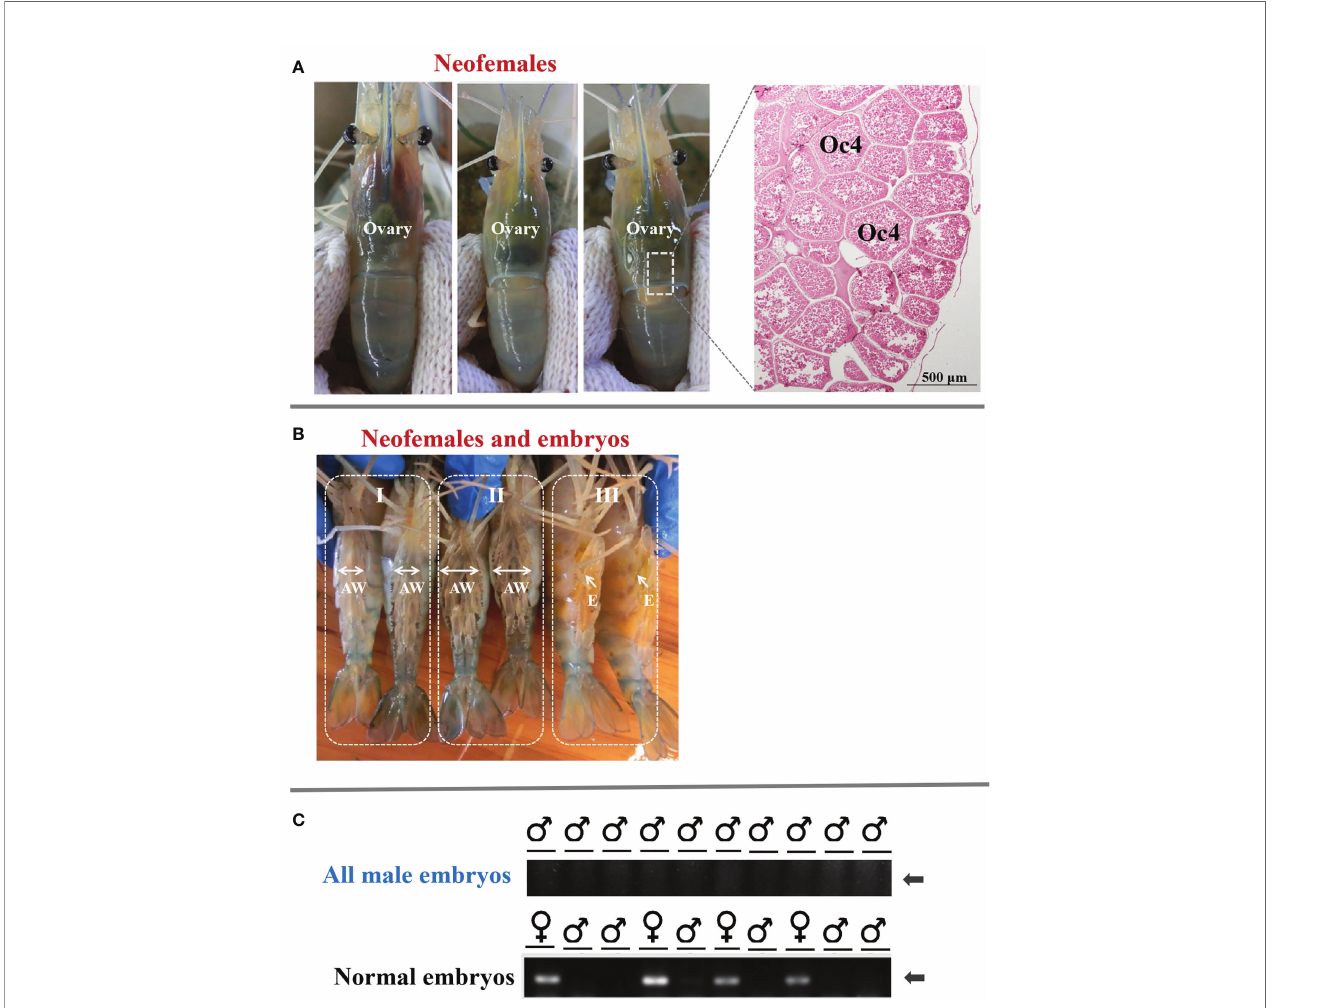
FIGURE 2 | The ovarian development of full-functional sex reversal prawn and the breeding of all-male progeny by MroDmrt11E -silenced prawn (neo-females). (A) The ovarian development and maturation of neo-females. The inset photograph indicated the histology of the mature ovary of neo-females. The ovary was full of mature oocytes (Oc4) that were intensely eosinophilic (reddish orange). (B) Ventral view of MroDmrt11E -silenced prawn (neo-females) incubating embryos in their brood chamber. The mature neo-females (B-I) spawned and incubated the embryos in their brood chambers, located ventrally on their enlarged abdomens (B-II, B-III). The color of embryos presented gradual changes from yellow to orange (B-III) then to light-gray color (B-II) during embryonic development. AW, abdomen; E, embryos. (C) Genomic validation of representative embryos from each progeny of neo-females. The fi rst row of PCR products was generated from neo-female embryos, and the second row was from normal females. The presented speci fi c band in gel electrophoresis implied the female